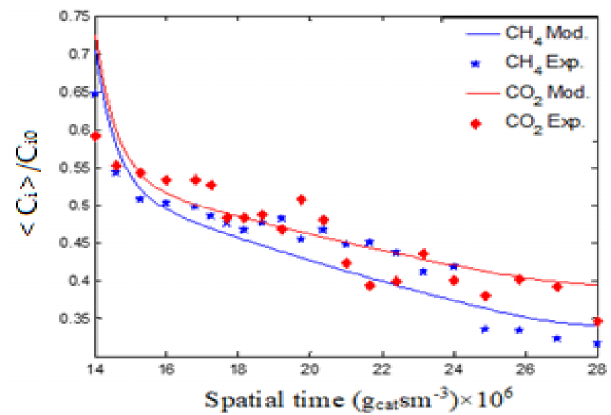
Figure 3. Evolutions of reagent concentrations as a function of spatial time. Conditions: Ni (4.86% wt.)/ γ -Al 2 O 3 catalyst, fluidized bed (280.0 g), 1.0 bar, 973K.